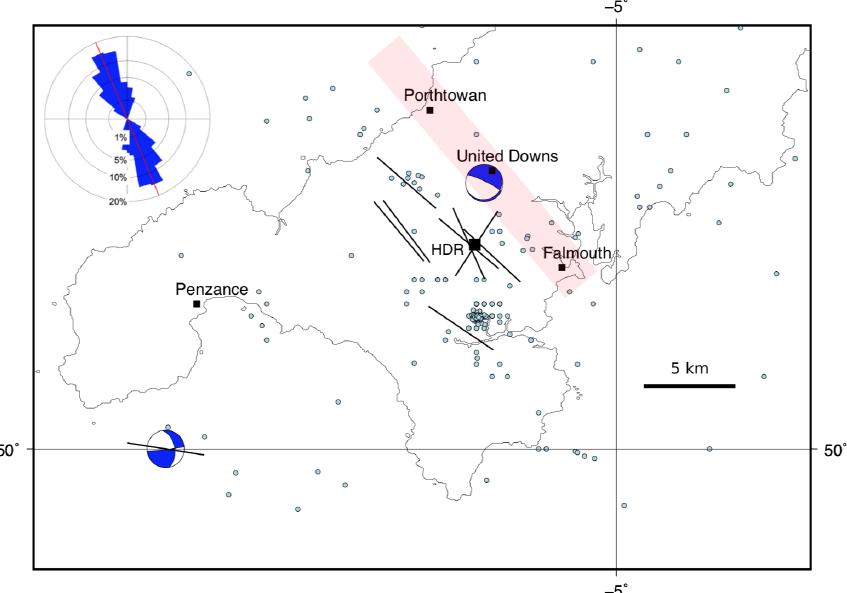
Figure 10. Map of southwestern England showing selected population centres, the United Downs deep geothermal pilot project, and the former Hot Dry Rock project (HDR; black squares); epicentres of seismicity (light blue dots; BGS catalogue; Musson, 1996); focal mecha- nisms (blue and white; Baptie, 2010); and orientations of the maximum horizontal stress (black lines; World Stress Map data; Heidbach et al., 2018). Approximate trend and extent of the Porthtowan Fault Zone shown in pale red. Inset shows an equal-area rose diagram with strikes of fault segments in the Porthtowan Fault Zone measured on BGS Falmouth sheet 352 ( N = 140; circular mean strike = 158 ◦ ; circular standard deviation = 27 ◦